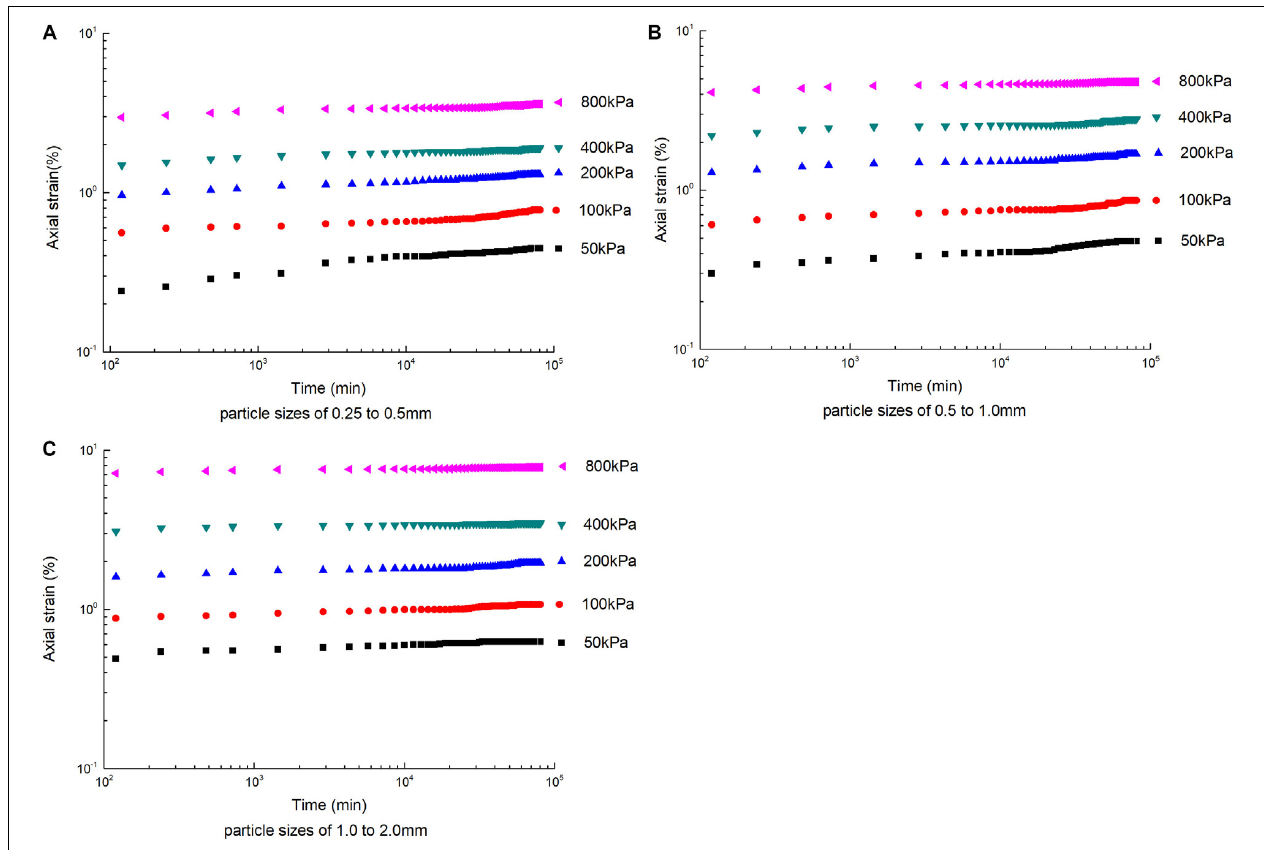
FIGURE 6 | Creep curve in logarithmic coordinates. (A) Particle sizes of 0.25–0.5 mm, (B) particle sizes of 0.5–1.0 mm, and (C) particle sizes of 1.0–2.0 mm.